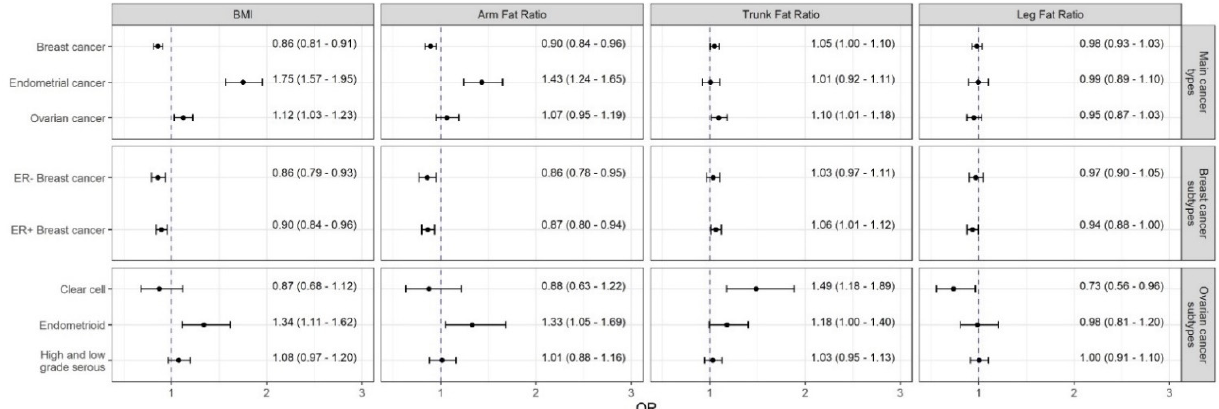
Figure 1. Causal estimates (odds ratios and 95% confidence intervals per one standard deviation change in the respective exposure) of the impact of obesity measures on female-specific cancers obtained by the radial inverse-variance weighted (IVW) approach with modified second-order weights. Abbreviations: FE, fixed effects; IVW (Mod. 2nd), inverse-variance weighted model with modified second-order weights; RAPS, Robust Adjusted Profile Score; RE, random effects; PRESSO, Pleiotropy RESidual Sum and Outlier.